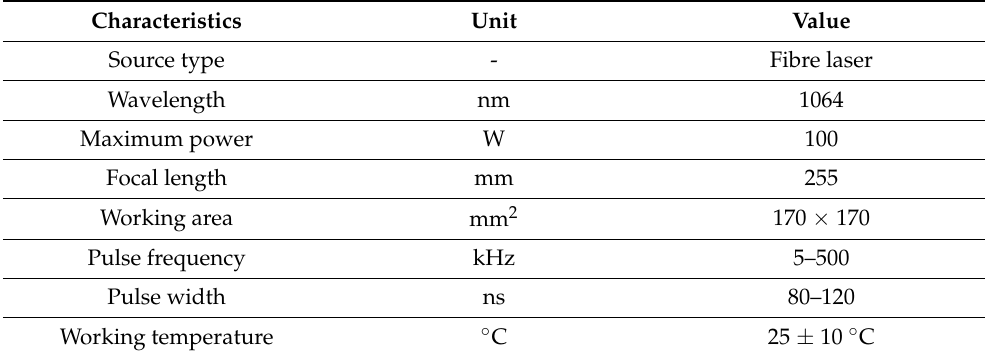
Table 4. Laser source characteristics.